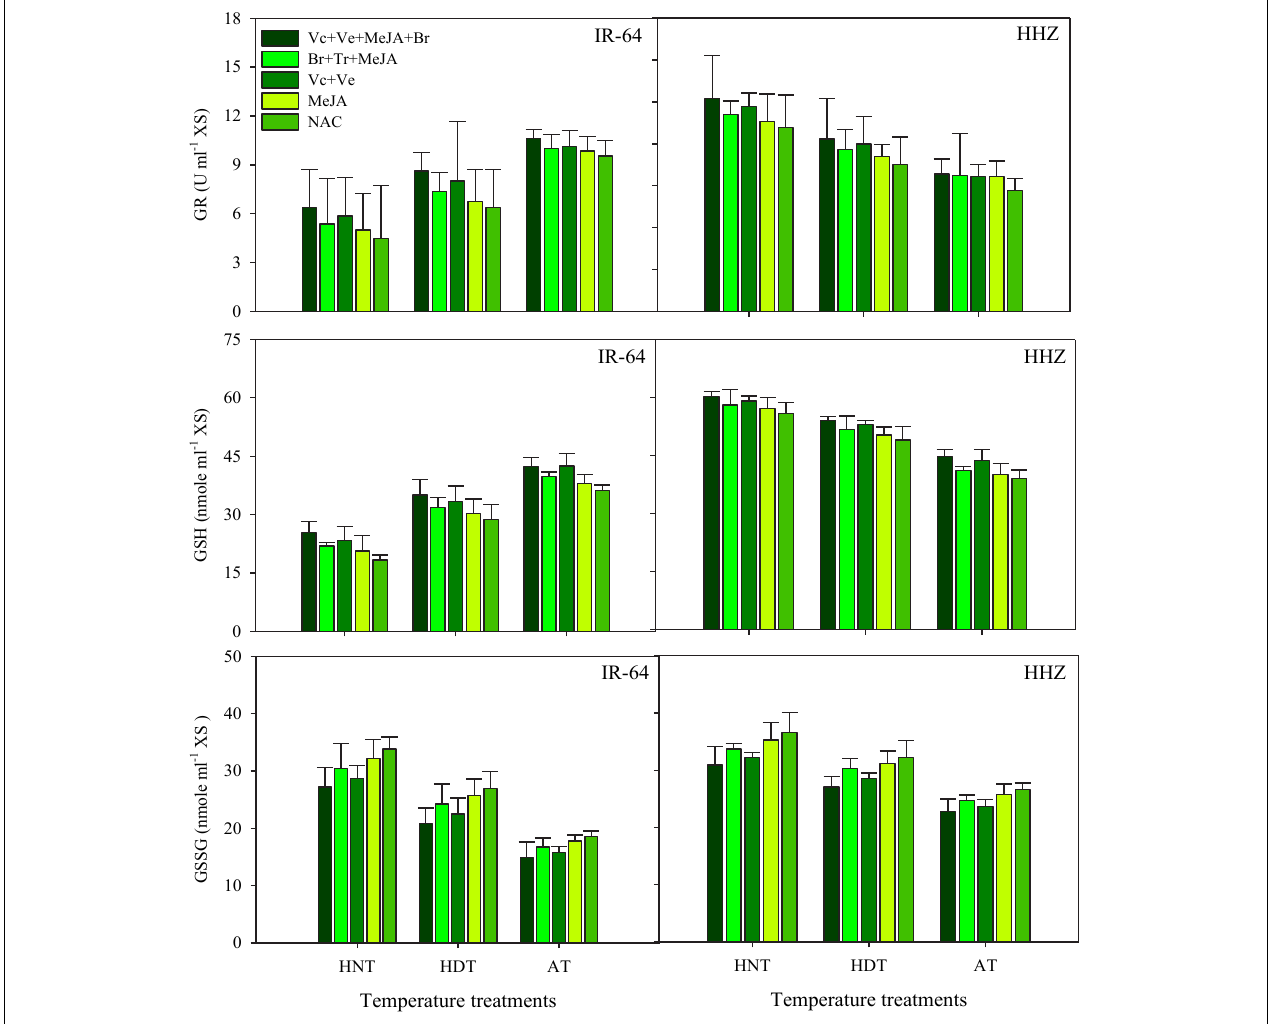
FIGURE 4 | Glutathione (GSH), glutathione reductase (GR), and glutathione disulfide (GSSG) concentration in the xylem sap as affected by growth regulators under heat stress. HDT, HNT, and AT stand for high day, high night, and ambient temperature, respectively. The lines on bars represent LSD value for the interaction of PGRs and heat stress (heat stress × PGR) at α =